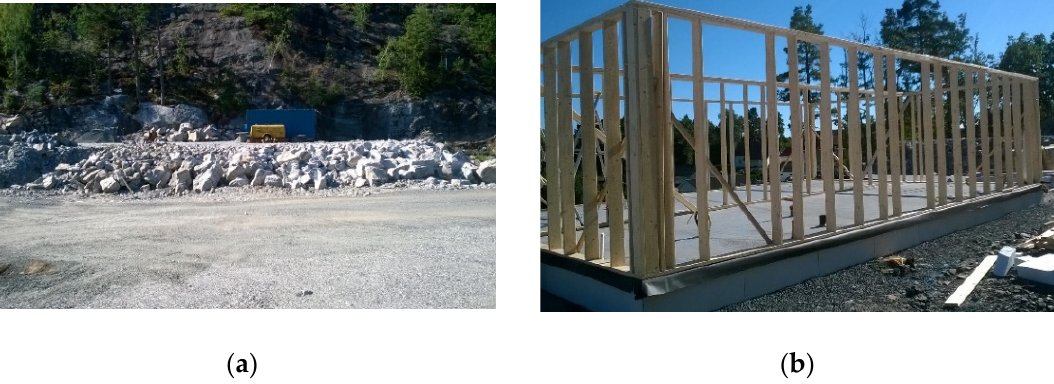
Figure 15. An example of a wooden building produced using Scandinavian technology: ( a ) blown up and then leveled rock yard prepared for the construction of a wooden frame house in Norway; ( b ) frame construction of a wooden house according to Scandinavian technology manufactured at the construction site.